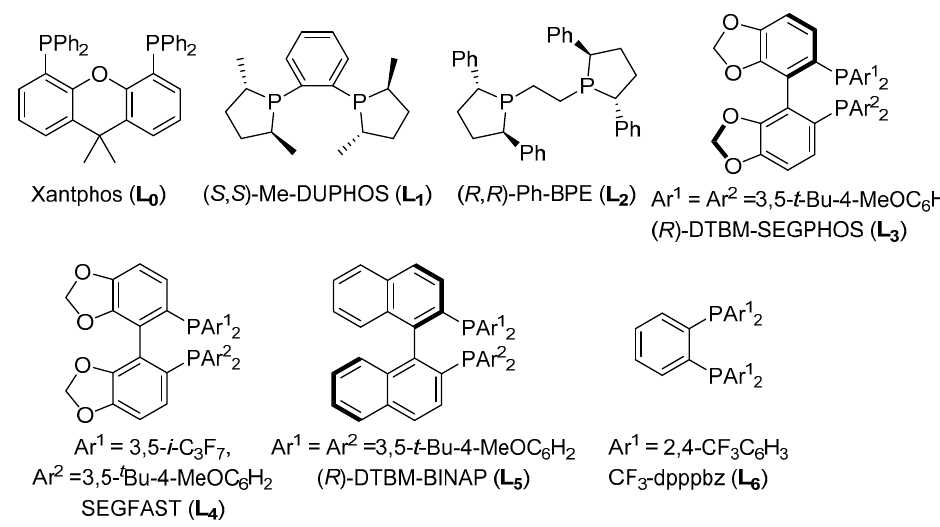
Figure 21. Bidentate biphosphine ligands used in Cu-catalyzed hydrofunctionalization reactions. Last year, inspired by their previous works on copper(II)-catalyzed enantioselective carboetherifications of alkenols [118–121], the group of Chemler reported the enantioselec- tive cyclohydroalkoxylation of a range of aliphatic 4- and 5-alkenols catalyzed by chiral copper(II) bis(oxazoline) (Figure 22 [122]. In the presence of an oxidant and an H-atom donor, the Cu(OTf) 2 /( S , S )- i -Pr-Box ( L 7 ) or ( S , S )-Ph-Box ( L 8 ) system is indeed an efficient system to access enantioenriched α -chiral substituted tetrahydrofurans, phthalans, isochro- mans and morpholine from primary and tertiary alcohols tethered to the terminal, 1,1- and 1,2-disubstituted alkenes as illustrated in Figure 22. This system is limited to ( E )-alkenes as ( Z )-isomers are less selective, affords higher enantioinduction for tertiary alkenols than primary alkenols and is unreactive for phenols. Isotopic labeling experiments and previous works are in favor of a polar/radical mechanism implying cis -oxycupration of the alkene followed by homolysis of the subsequent σ -Cu–C bond and H-atom transfer. Oxidation of the Cu(I) to Cu(II) species completes the catalytical cycle.